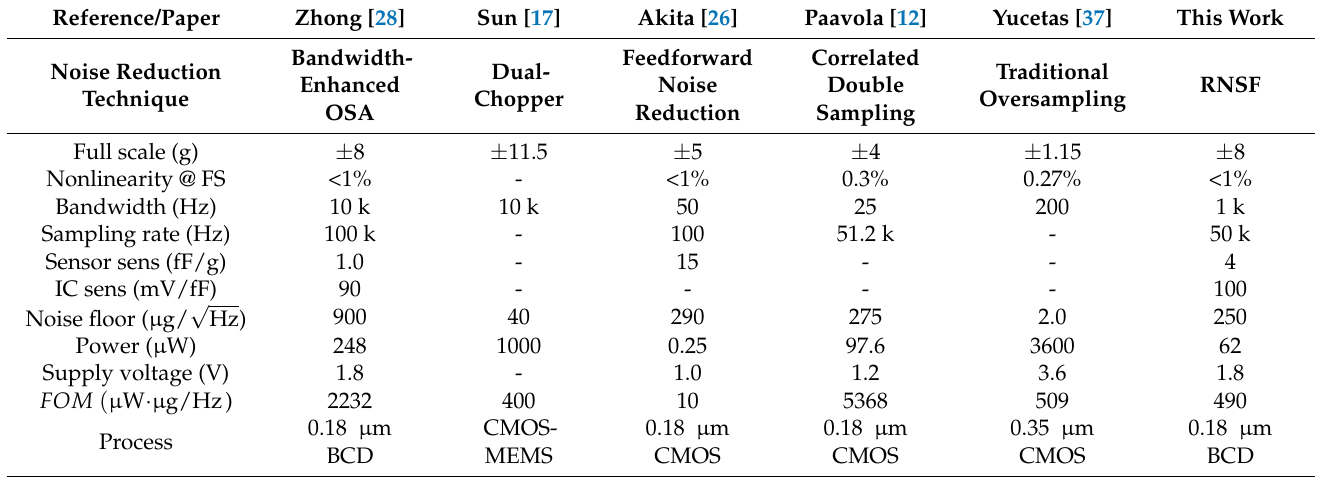
Table 3. Comparison of readout circuit for open-loop MEMS capacitive